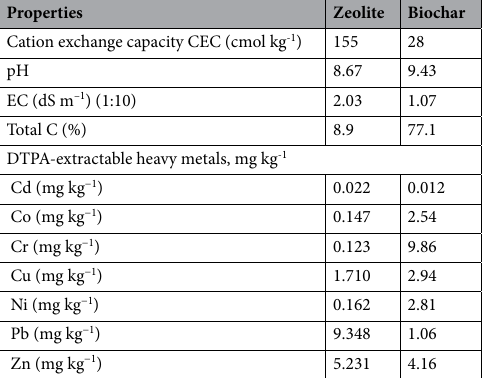
Table 4. Selected properties of studied biochar and